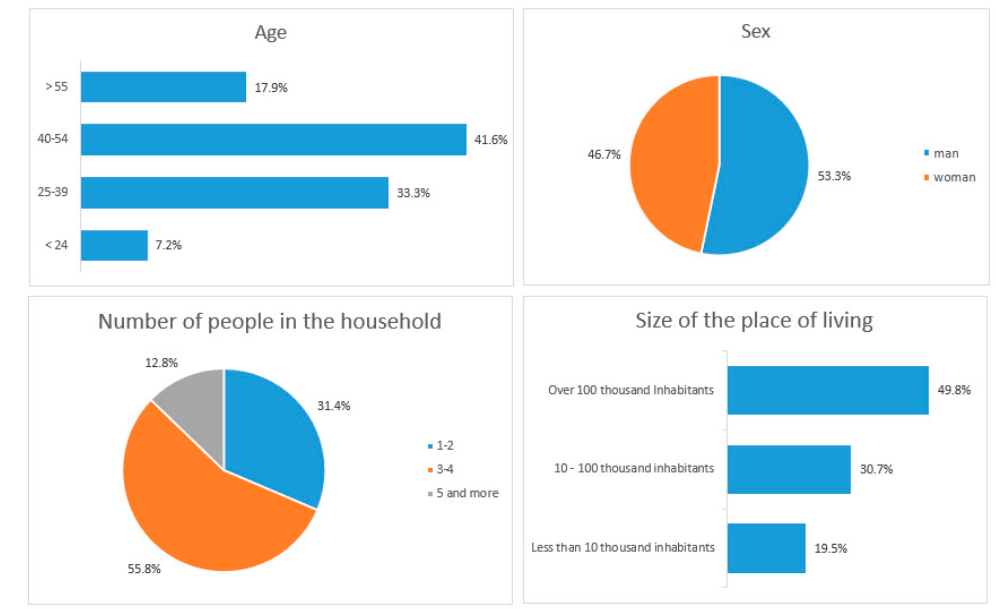
Figure 3. Research sample characteristics. Source: own work.